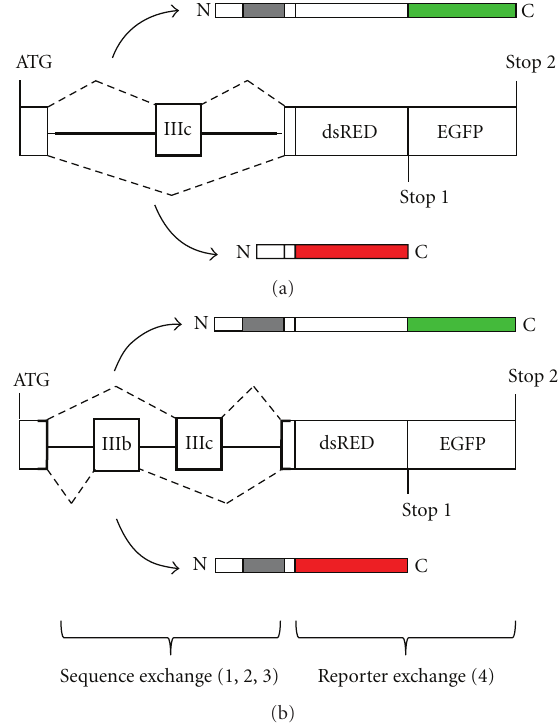
Figure 4: IIIb/IIIc splice reporter systems. Schematic of bichro- matic fluorescence reporter constructs for IIIc (a) and IIIb/IIIc (b) analyses with adaptations from [90] and [92]. The reporter genes are positioned downstream of the splicing cassette (bold) in two di ff erent reading frames, each containing an individual stop codon. Inclusion of exon IIIc (and for b simultaneous skipping of IIIb) of FGFR2 results in a fusion protein in frame with EGFP (green) ending at stop codon 2. Skipping of this exon (and for b simultane- ous inclusion of IIIb) results in DsRED (red) expression in another reading frame which contains stop codon 1. Possible adaptations of this splicing reporter system are indicated to exchange (1) species specific orthologous sequences, (2) sequences from IIIb splice vari- ants, (3) sequences from paralogous FGFR 1 and 3, and (4) sequen- ces for other fluorescence reporter